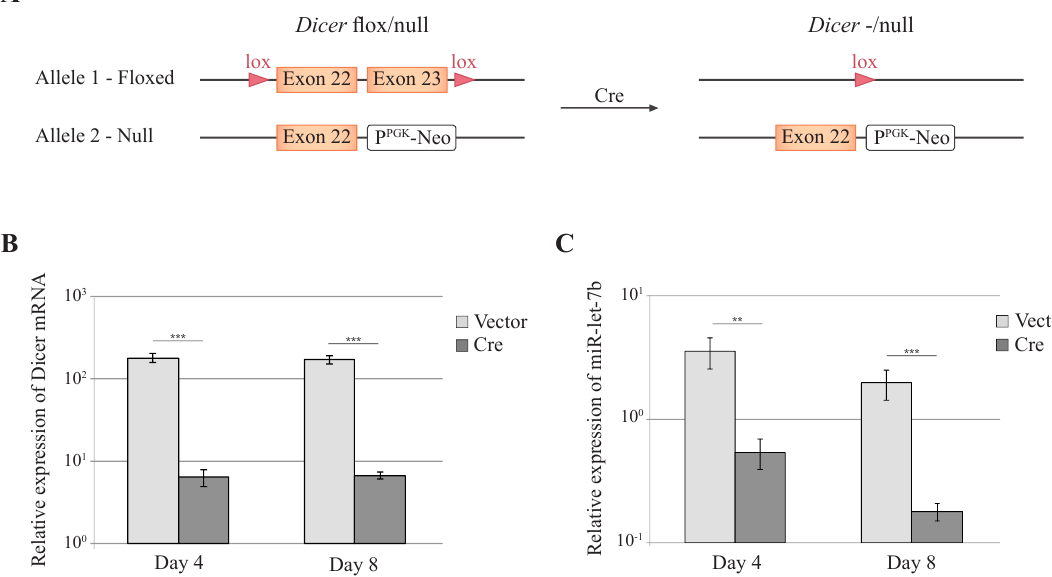
Figure 2. Short-term Dicer inactivation influence on cellular miRNA expression. ( A ) Illustration of Dicer alleles present in MEFs before and after Cre-mediated recombination; ( B , C ) Four and 8 days after transduction of Dicer flox/null MEFs with either TM945 expressing mCherry alone (Vector) or ADC82 co-expressing mCherry and Cre (Cre), WT Dicer mRNA ( B ) and mature miR-let-7b ( C ) were quantified by qRT-PCR. Graphs show the mean and standard deviation (SD) of a typical experiment (out of 2) performed in triplicate. ** p < 0.01, *** p <